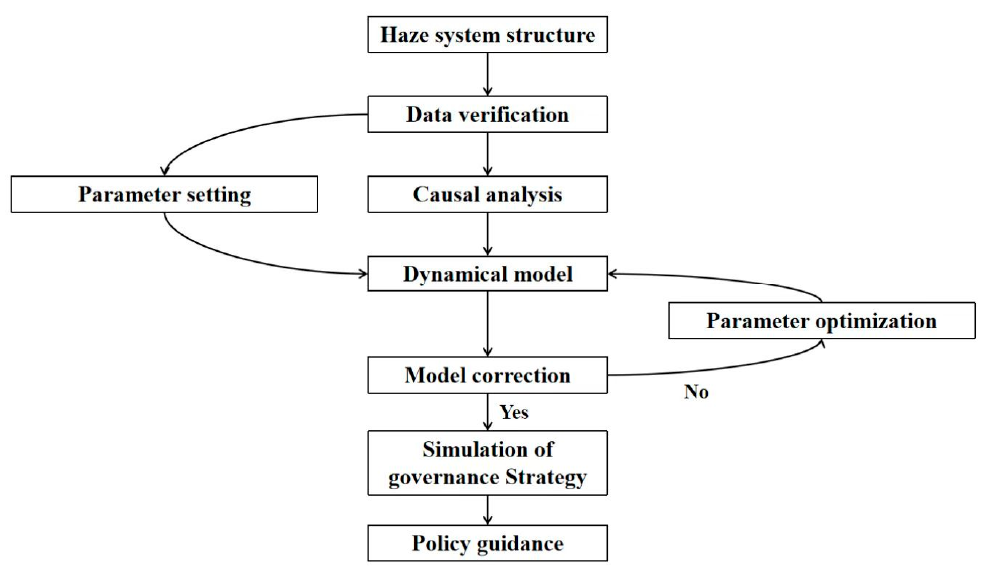
Figure 1. Flowchart of haze system model.